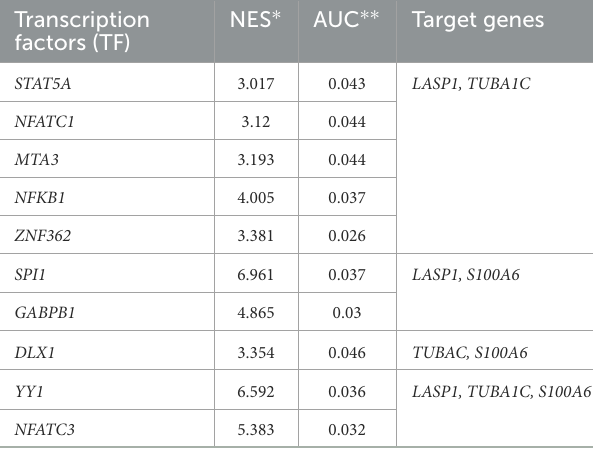
TABLE 4 The top 10 transcription factors (TFs) estimated to affect hub